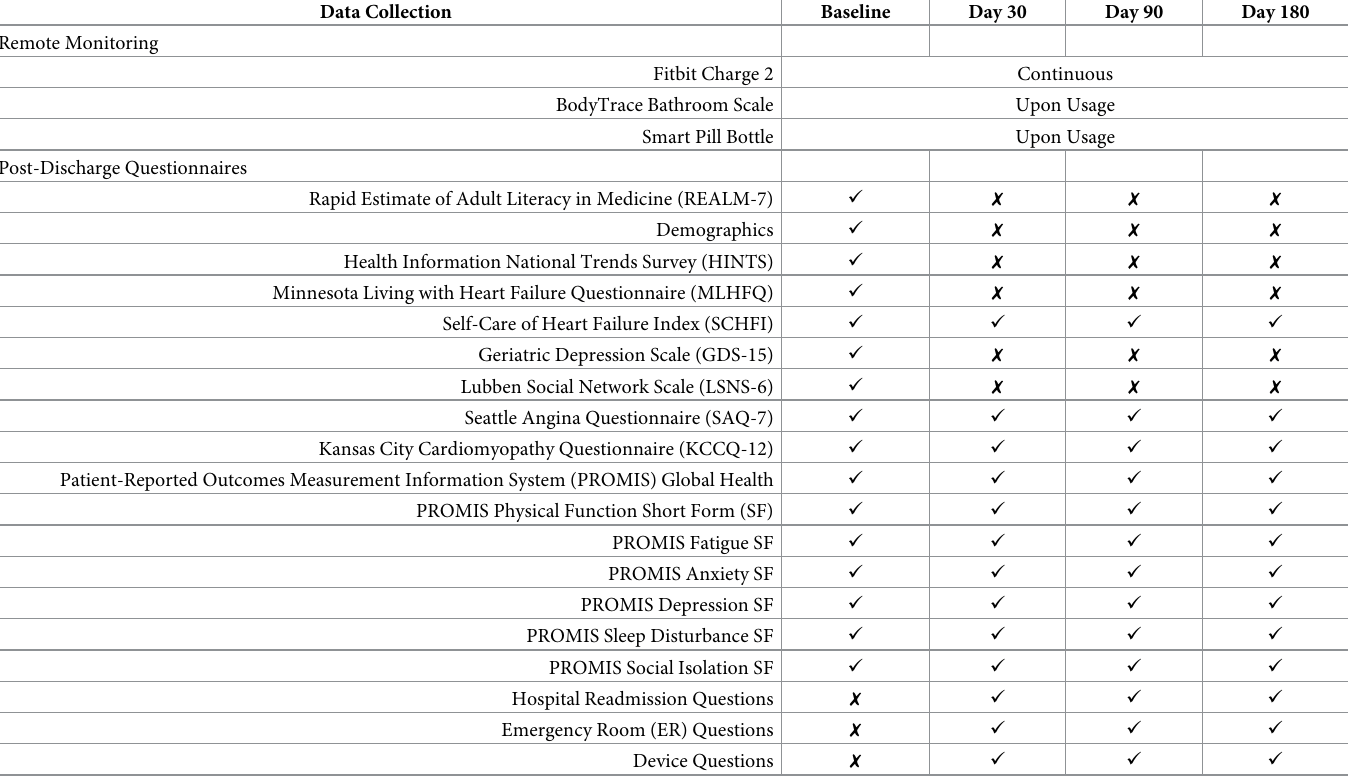
Table 1. mHealth for heart failure protocol data